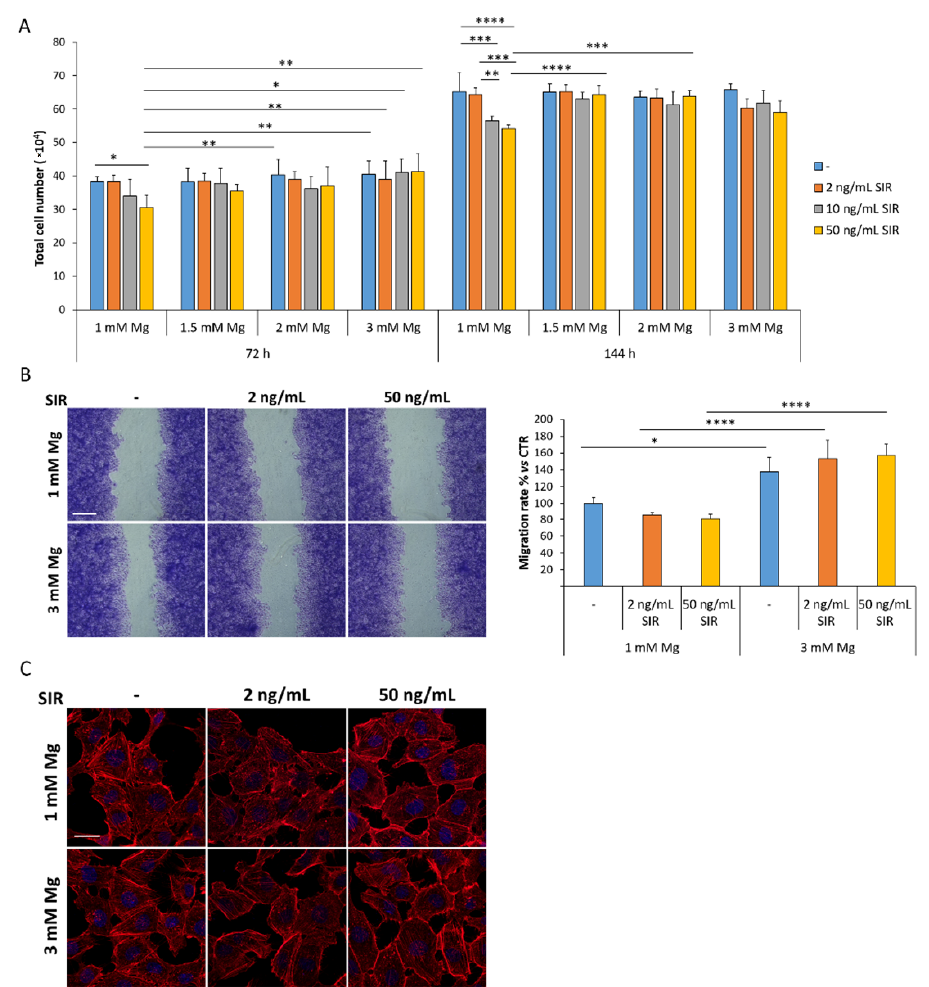
Figure 1. The effects of sirolimus and Mg on rCAEC. ( A ) rCAEC were counted after 72 and 144 h of culture in medium containing 1, 1.5, 2 or 3 mM Mg with or without different concentrations of sirolimus (SIR, 2, 10, 50 ng/mL). -SIR refers to untreated controls. ( B ) Confluent rCAEC were cultured in the presence of 1 or 3 mM Mg combined with 2 or 50 ng/mL of sirolimus for 48 h. Then wound assay was performed. 24 h later the width of the wound was visualized and measured. Representative images of the scratches are shown (left panel). Scale bar: 125 µ m. The migration rate was analyzed using ImageJ and data are shown as the percentage of migration compared to the control (CTR, 1 mM Mg without sirolimus, right panel). ( C ) Confluent rCAEC were cultured in culture medium containing 1 or 3 mM Mg with or without sirolimus (2 and 50 ng/mL), stained with phalloidin and DAPI and visualized by fluorescence microscopy. Representative images are shown. Scale bar: 20 µ m. Data are expressed as the mean ± standard deviation of three independent assays (* p ≤ 0.05; ** p ≤ 0.01; *** p ≤ 0.001; **** p ≤ 0.0001).